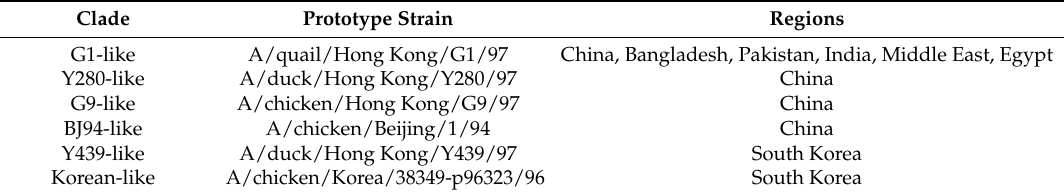
Table 2. Clades of H9N2 viruses isolated from